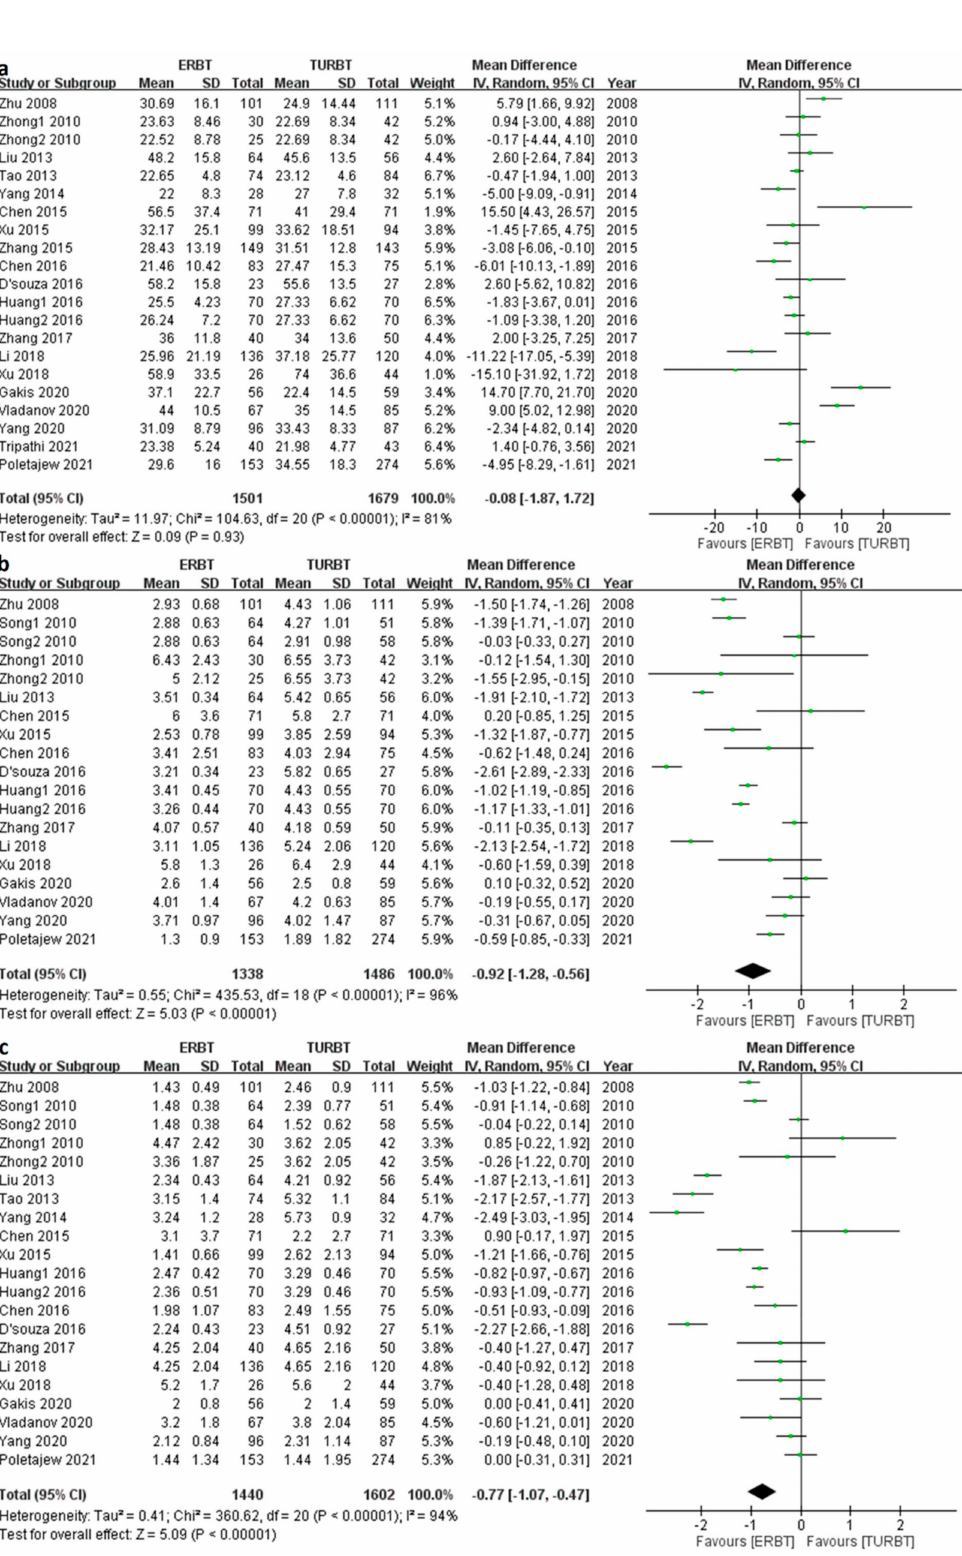
Figure 4. The forest plot of perioperative outcomes. ( a ) The forest plot of operation time. ( b ) The forest plot of hospitalization time. ( c ) The forest plot of catheterization